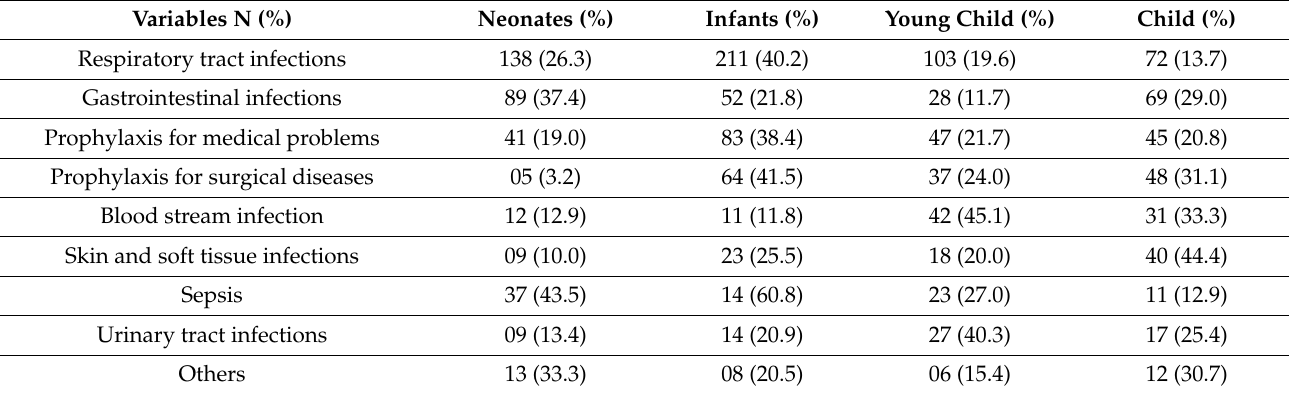
Table 5. Indications for prescribed antibiotics according to age